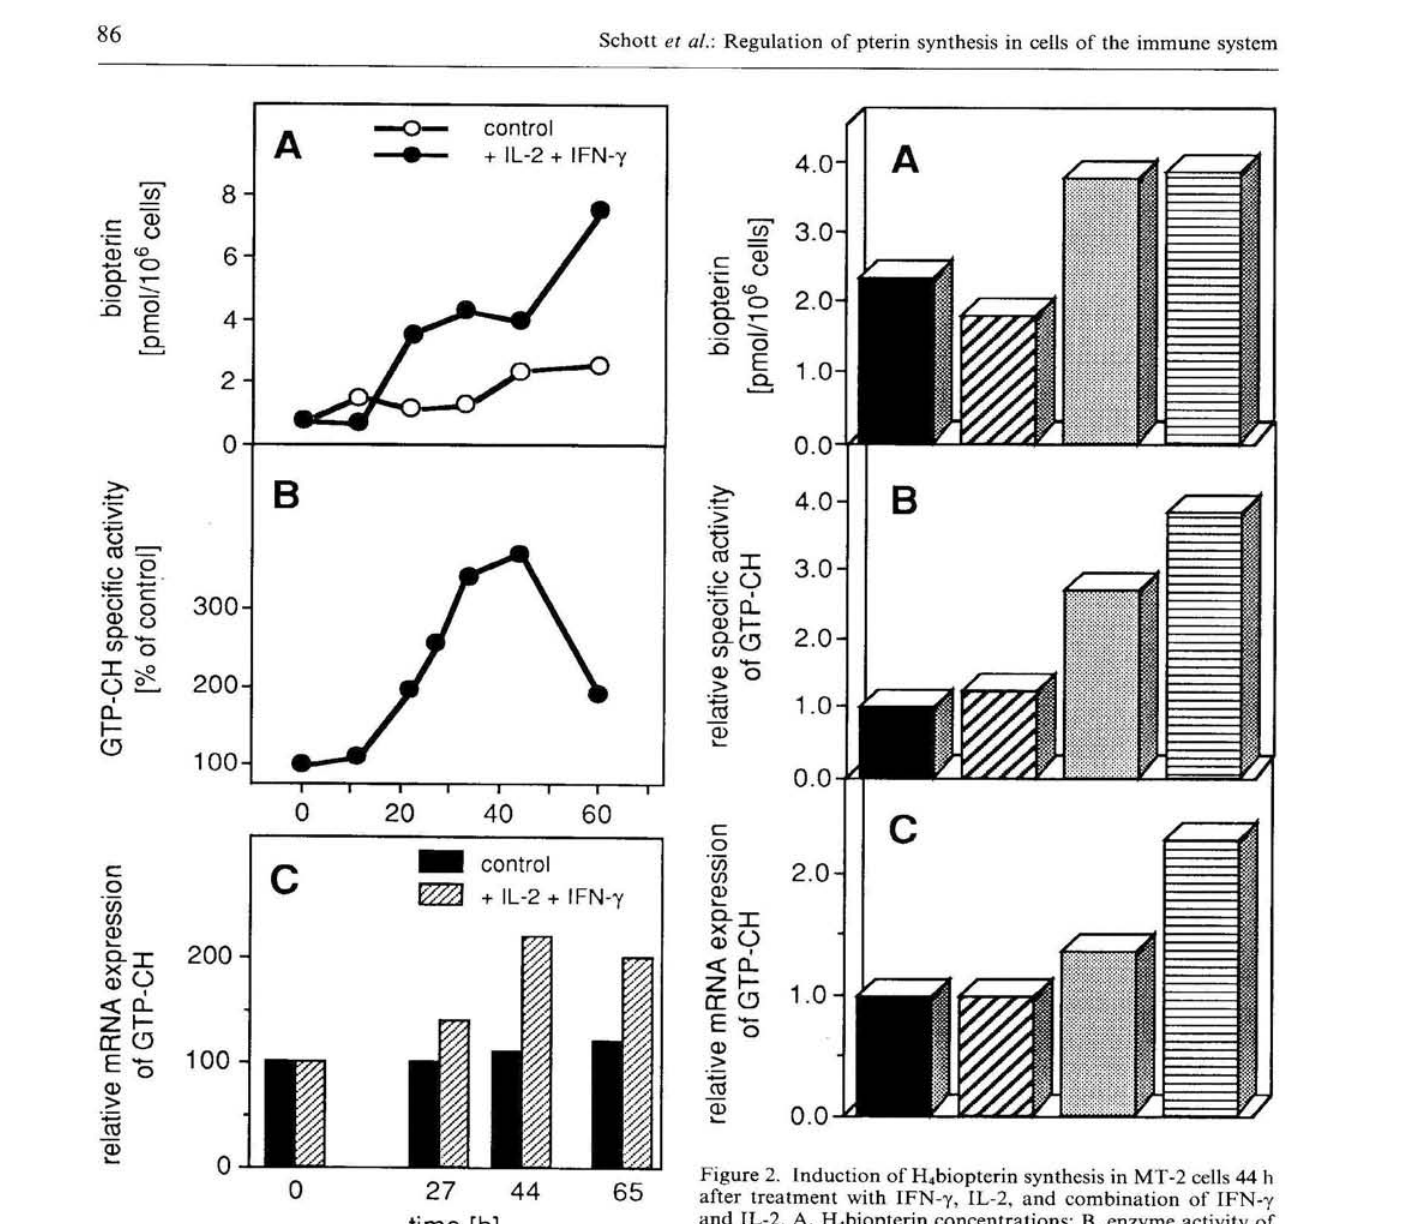
Figure 2. Induction of H 4 biopterin synthesis in MT-2 cells 44 h after treatment with IFN-γ, IL-2, and combination of IFN-γ and IL-2. A, H 4 biopterin concentrations; B, enzyme activity of GTP-cyclohydrolase I; C, relative mRNA expression. controls; IL-2 (20 U ml" 1